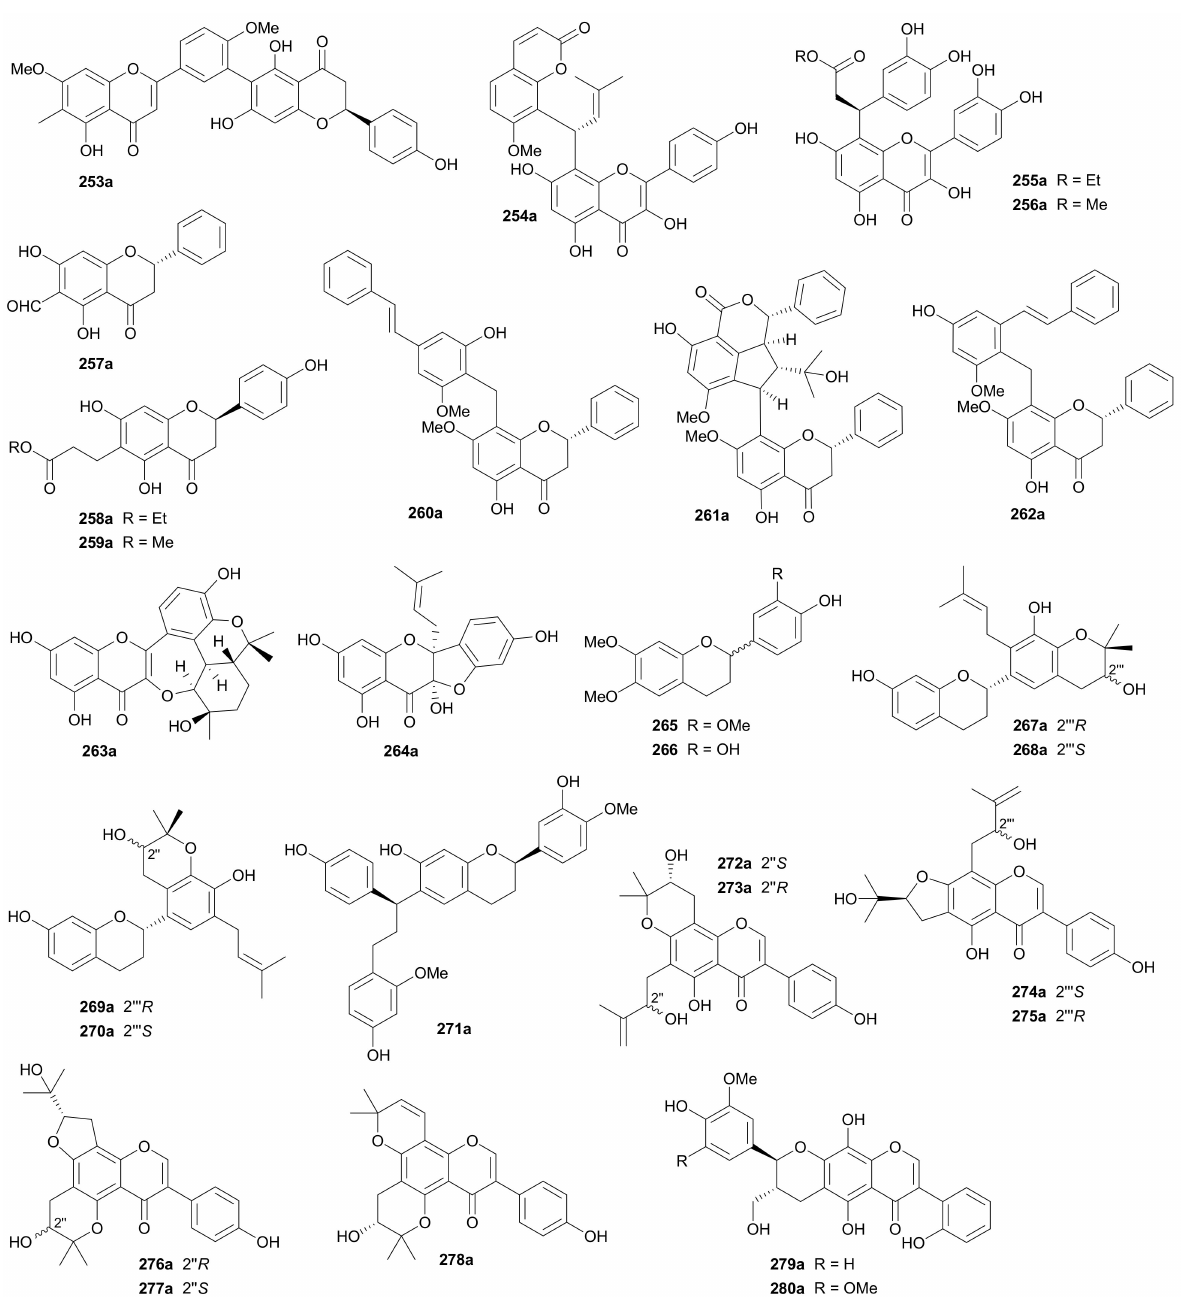
Figure 15. Structures of flavones and